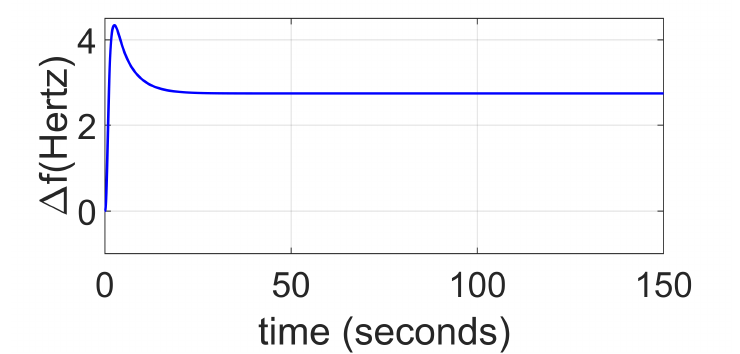
Figure 11. Frequency measurement under negative bias injection attack. The location based attack is also a serious type of attack. The most common type in this category is load attack. The simulation studies for such type of attack with ∆ P L = 0.01 + δ where δ is Gaussian random signal with mean zero and variation 0.1 is shown in Figure 12. It is clear that the frequency measurements are fluctuating around the zero base line.